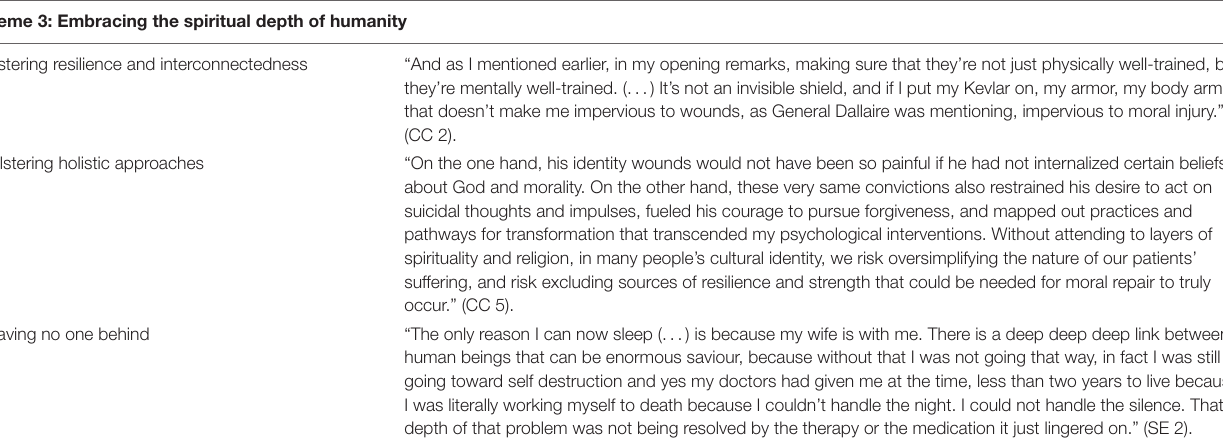
TABLE 5 | Additional supporting quotes for the theme “embracing the spiritual depth of